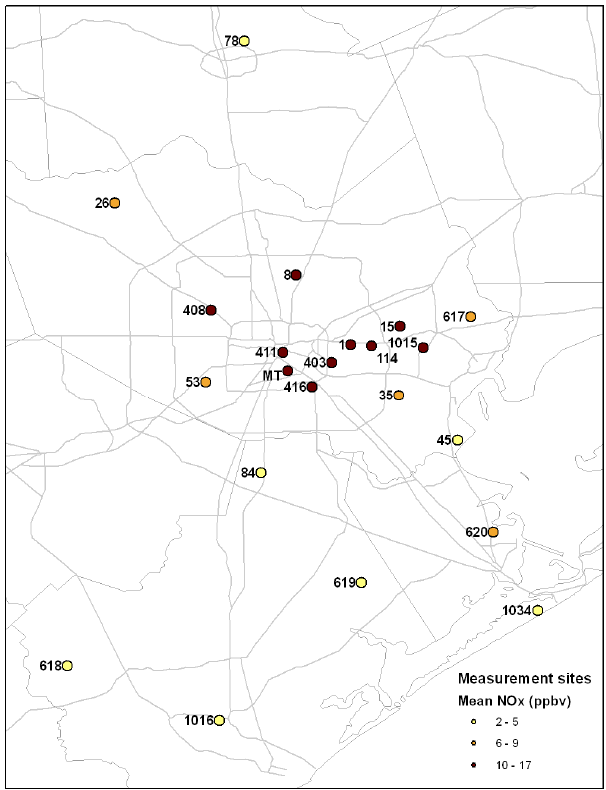
Figure 1. Locations of stations performing NO x measurements